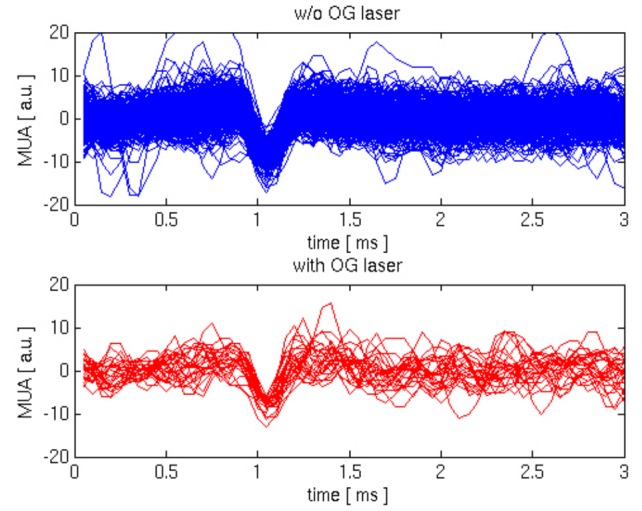
DOI:
http://dx.doi.org/10.7554/eLife.14315.016